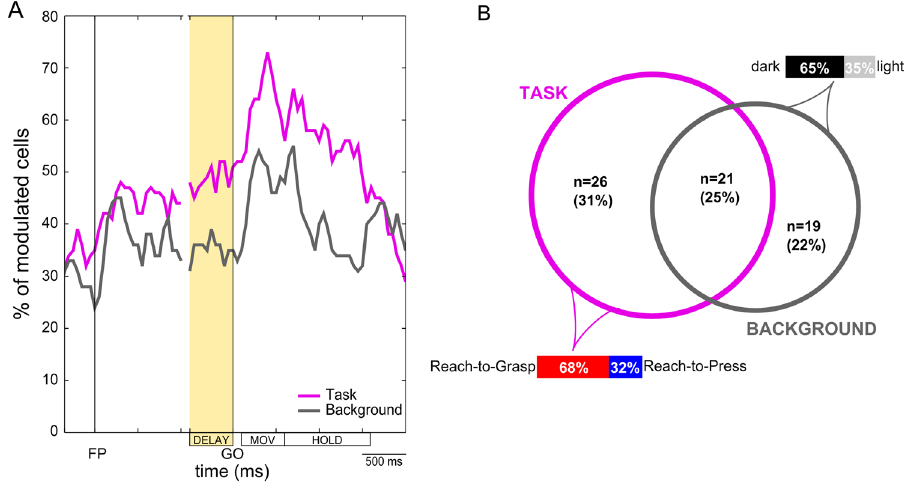
Figure 2. General assessment of modulations in the population of V6A neurons. ( A ) Percentage of cells in the population with task preference (magenta) and background sensitivity (dark gray) in sliding windows (width: 200 ms, shift: 50 ms) covering the whole duration of the trial (sliding window ANOVA, p < 0.05). ( B ) Schematics of task-related and background-related modulations measured during the DELAY epoch. The graph reports the number and percentage of cells showing a main effect of Task (magenta circle), a main effect of Background (dark gray circle) or both effects (intersection) (repeated-measures ANOVA, p < 0.05). Colored bands represent the general incidence of task preference for reach-to-grasp (68% considering all task-selective cells; red) vs. reach-to-press (32% considering all task-selective cells; blue) movements (bottom left), and the incidence of background preference for dark (65% considering all background-selective cells; black) or light (35% considering all background-selective cells; light gray) background (up right), respectively, within the whole population of modulated